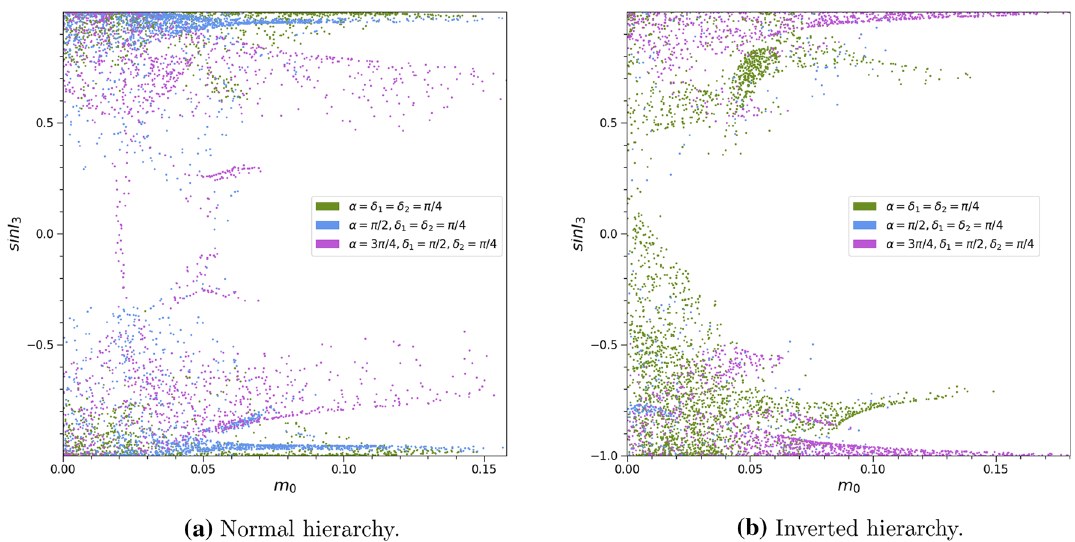
Fig. 10 sin I 3 as a function of the lightest neutrino mass m 0 for non-zero Majorana